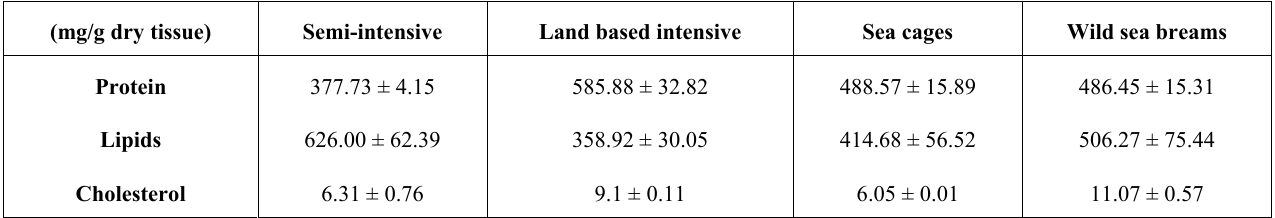
Table 1. Hepatic protein, lipids and cholesterol contents for the three different rearing systems, and wild samples (control) at the end of trial. Each value represents mean ± SD of 3 replicates.